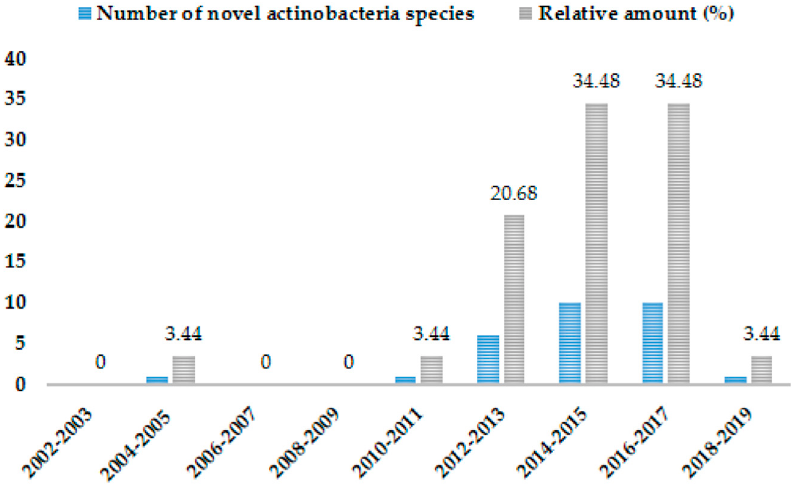
Figure 3. Variation in number of culturable novel actinobacteria species collected from Algerian sources since 2002.